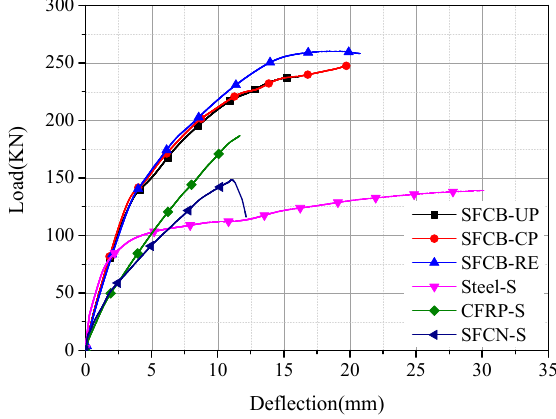
Figure 12. Load-deflection curves for the hybrid-reinforced beams with SFCB.